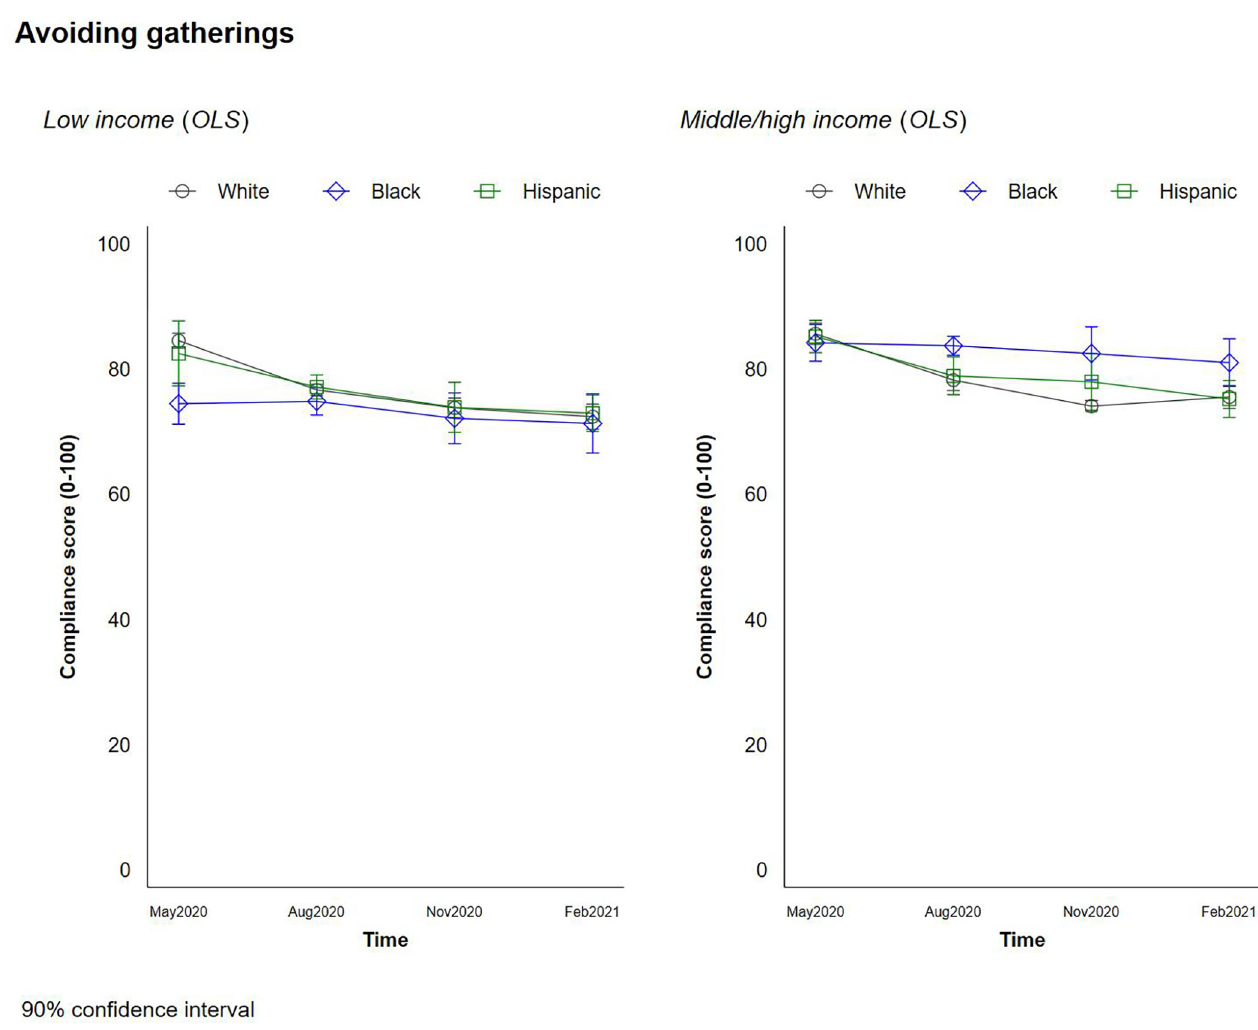
Fig 8. Changes in social distancing behaviors by race and income–avoiding social